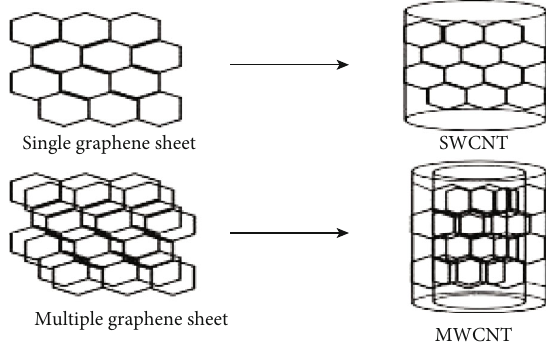
Figure 2: Structure of SWCNT and MWCNT.